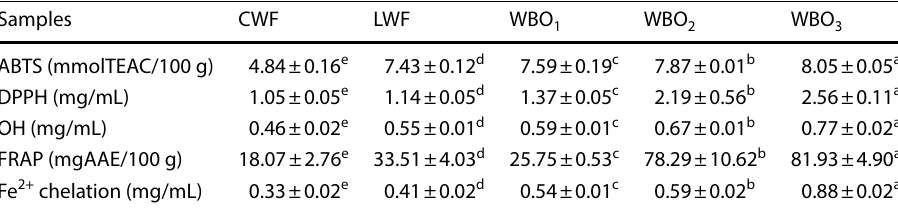
Means ( ± SD) with different alphabetical superscripts in the same row are significantly different at P < 0.05. [75% wheat, and 25% bambara groundnut